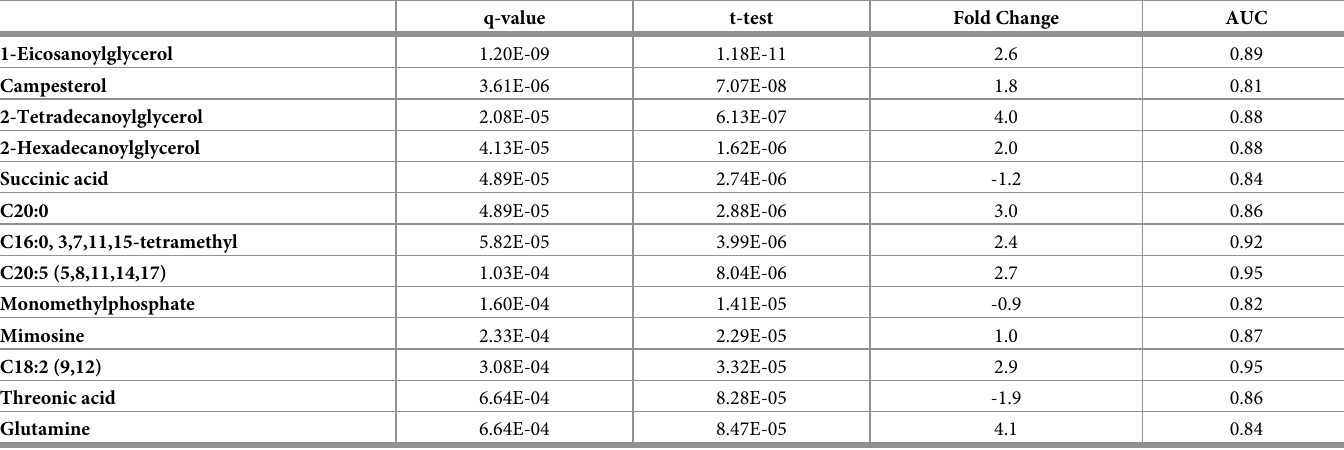
Table 2. List of liver metabolites that differed between bigheaded carp (silver carp Hypophthalmichthys molitrix and bighead carp H . nobilis) sampled from leading edge vs. downstream locations within the Illinois River. q-value t-test Fold Change